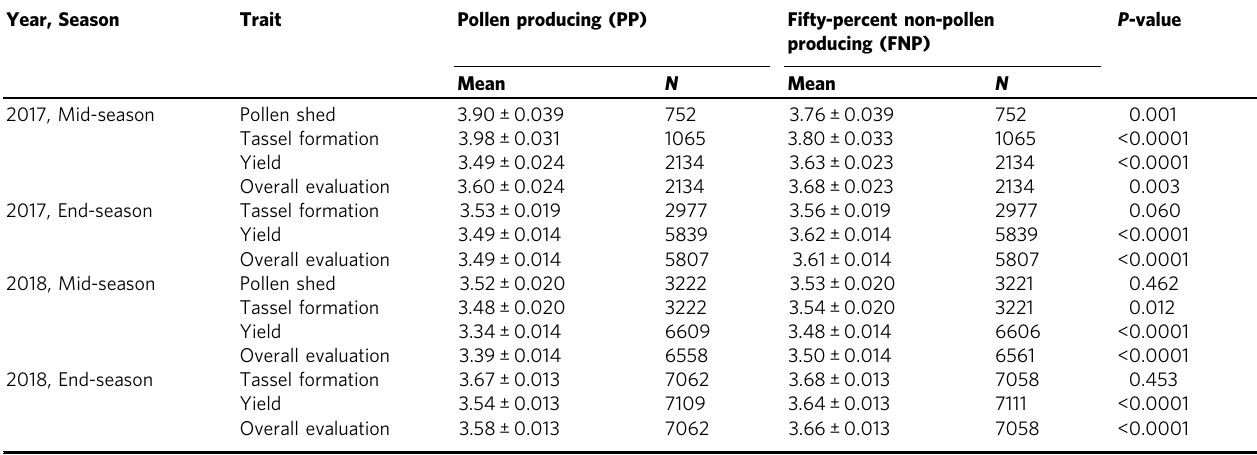
Table 2 Farmers prefer 50% non-pollen producing (FNP) hybrids over conventional (PP)